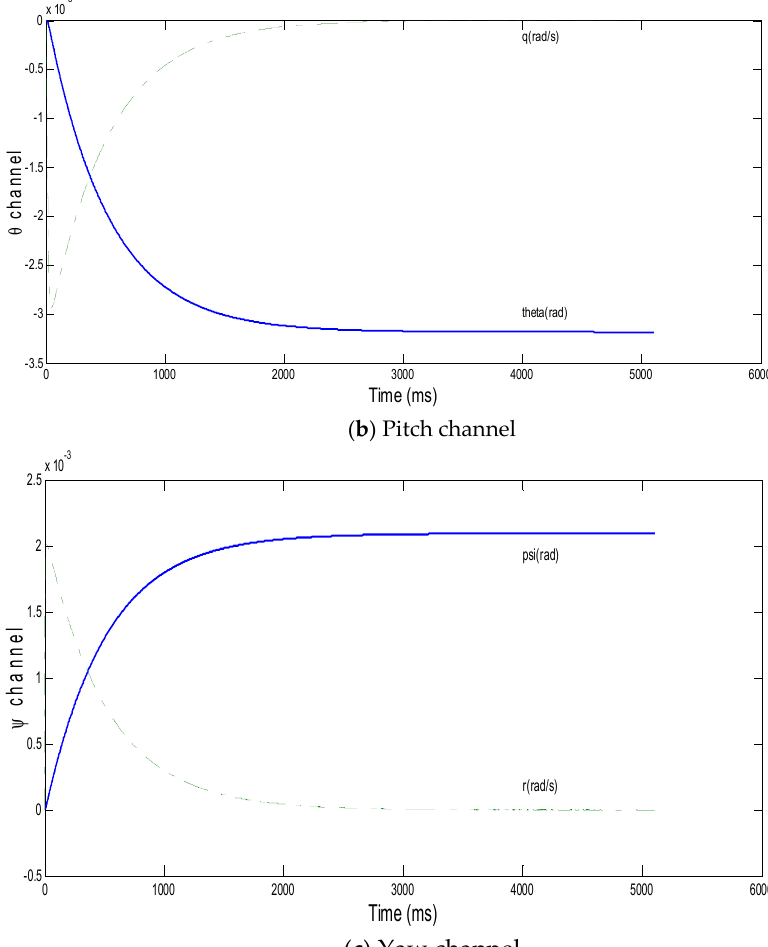
Figure 4. Tricopter hovering mode with linear quadratic regulator (LQR) control in each channel: ( a ) roll, ( b ) pitch and ( c ) yaw.